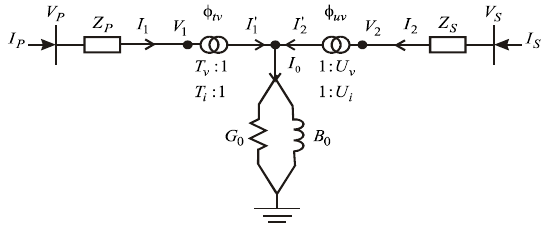
Figure 2. T model for the transformers.